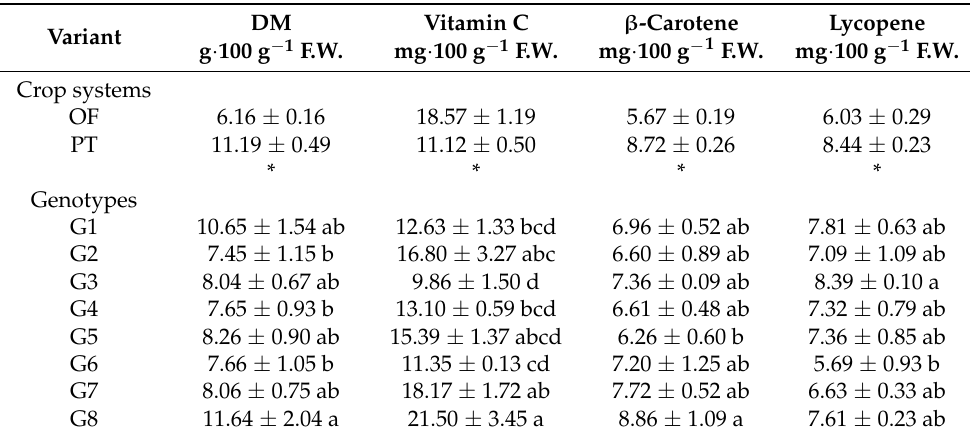
Table 4. The influence of the crop system and genotypes on the antioxidant compounds. DM Vitamin C Variant g · 100 g − 1 F.W. mg · 100 g − 1